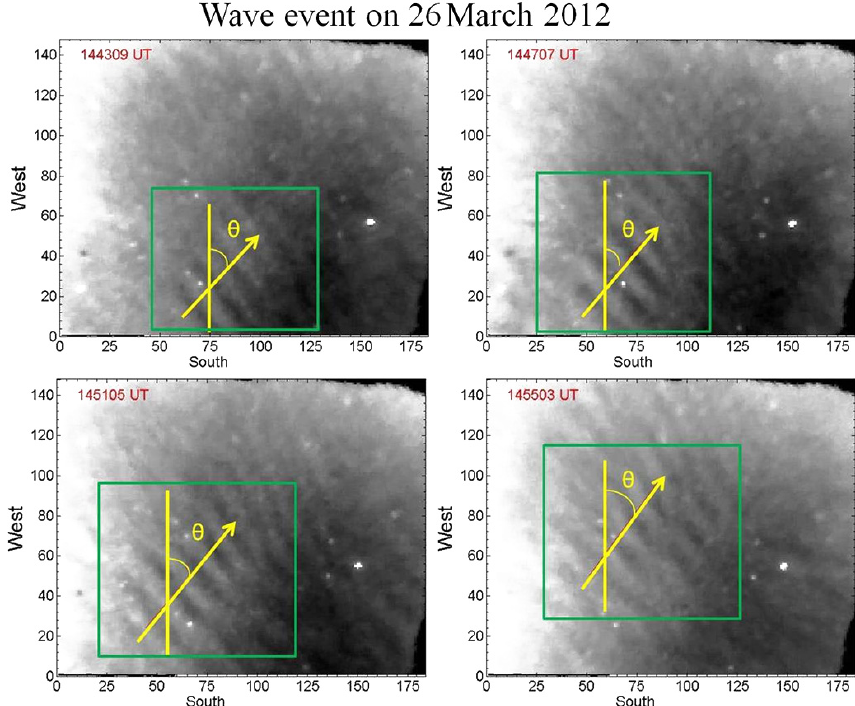
Figure 1. A sample figure of observed gravity wave event in OI557.7nm emisison on 26 March 2012. The yellow arrows reveal their propagation direction at an angle (cid:50) (angle of increment is from 0 ◦ north clockwise). The green-colored box shows the dominant wave fronts. p (x 2 − x 1 ) 2 + (y 2 − y 1 ) 2 ) . In the case fined as d =